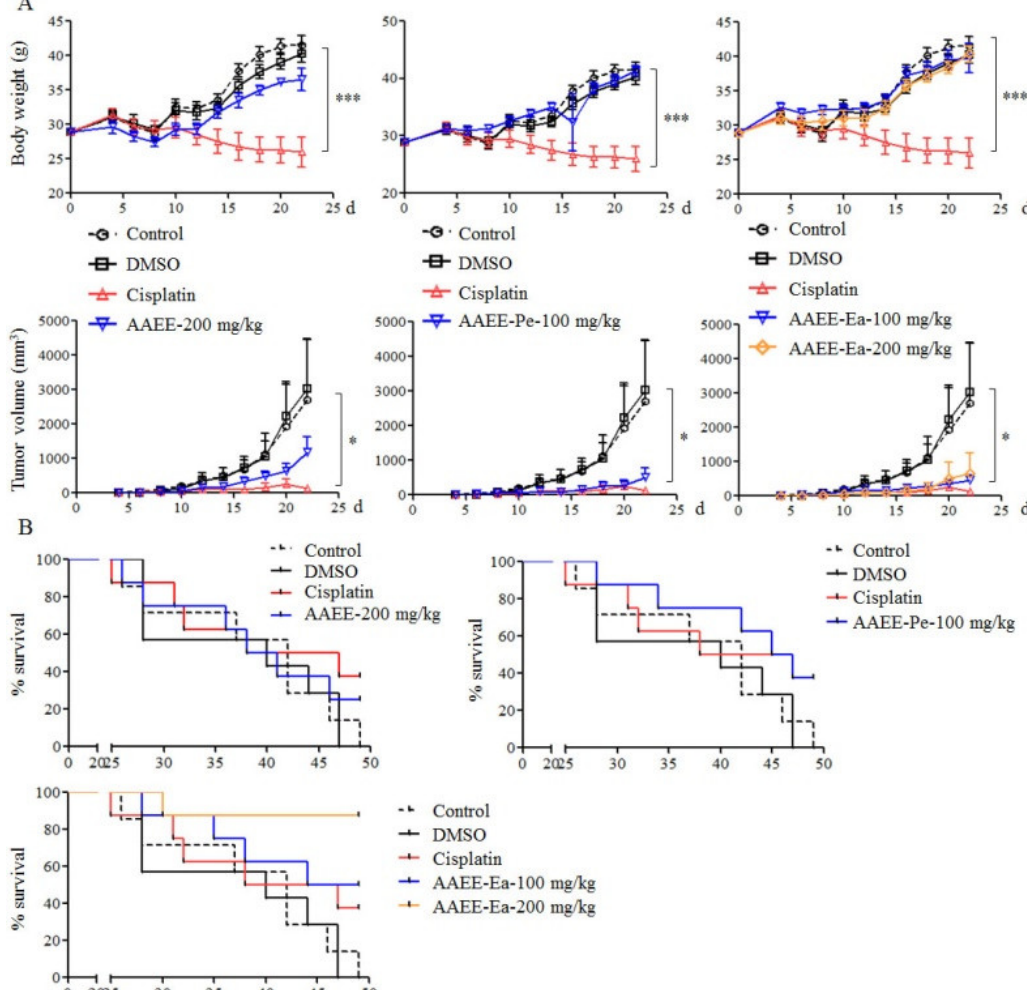
Figure 6. AAEE, AAEE-Pe, and AAEE-Ea suppressed tumor growth in vivo. A tumor mouse model was established by injection of H22 cells. After 3 days, tumor mice were treated with DMSO, cisplatin, AAEE, AAEE-Pe, and AAEE-Ea. Body weight of mice, tumor sizes ( A ), and survival rates ( B ) were monitored at the indicated time points. * p < 0.05; *** p < 0.001 compared to control.